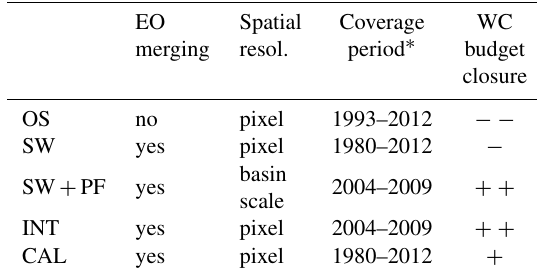
Table 3. Main characteristics of the five merging methods in this study: EO stands for Earth observation satellite datasets, and ∗ means not considering the GRACE period coverage. The last column shows the capability of the methodology to close the WC budget. “ − − ” means bad closure, “ − ” means quite bad closure, “ + ” means quite good closure and “ + + ” means good